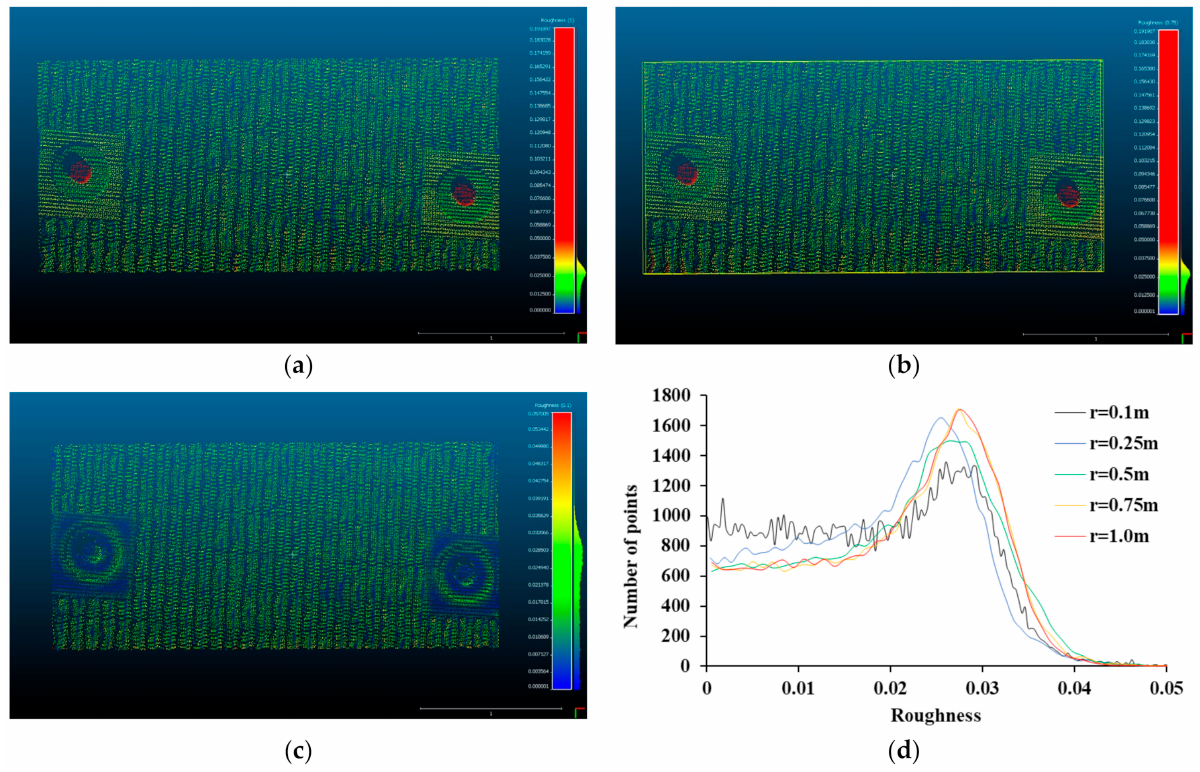
Figure 5. Roughness of concrete panel, ( a ) Kernel radius = 1.0 m, ( b ) Kernel radius = 0.5 m ( c ) Kernel radius = 0.1 m, ( d ) Histogram of